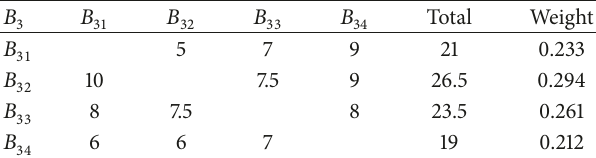
Table 15: Judgment matrix of 𝐴 − 𝐵